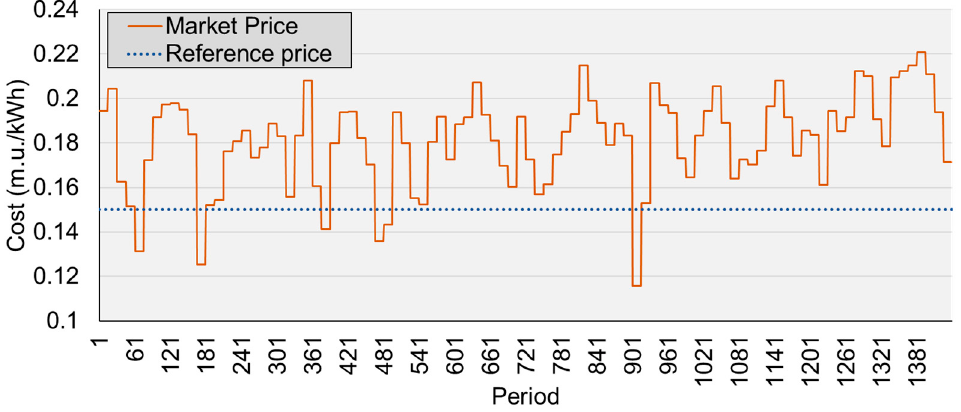
Figure 5. Electricity market and reference prices considered in the case study.